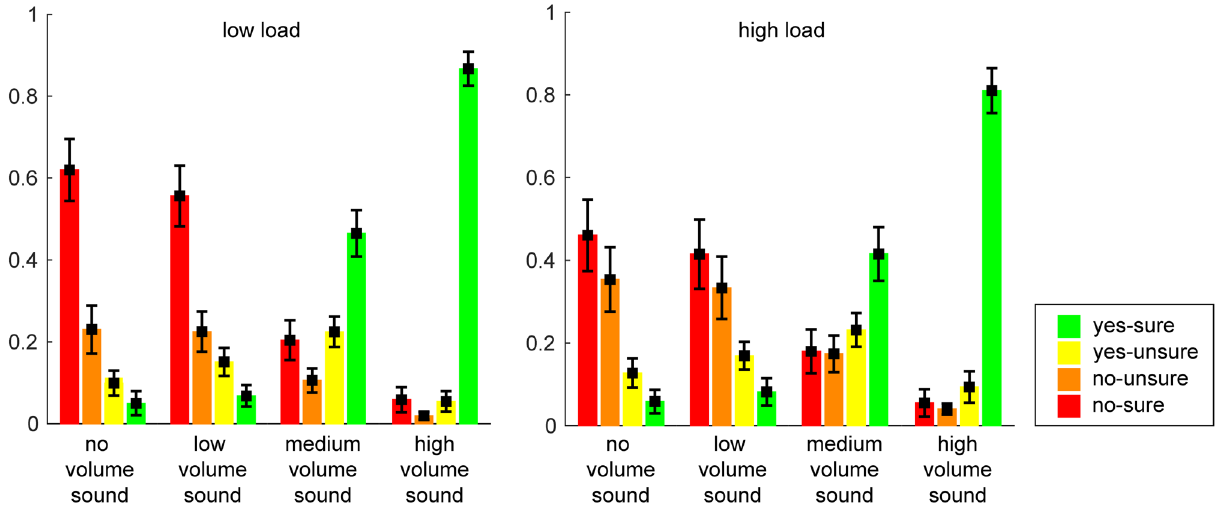
Figure 4. Mean distribution of the four response categories for each sound condition and the two load